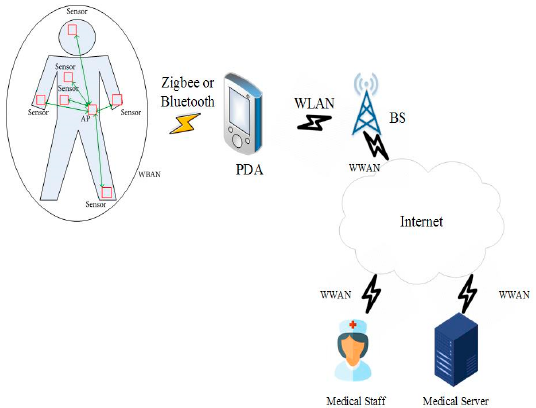
Figure 7. Bluetooth technology in the wireless body area network [19].